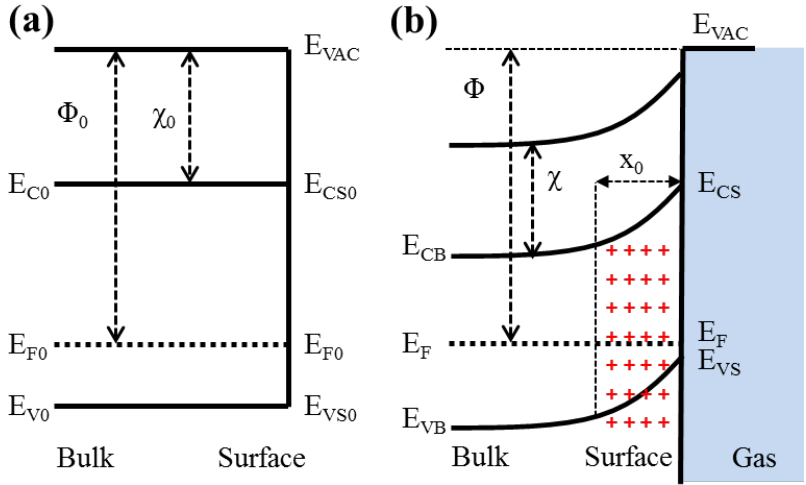
Figure 4. Band model showing the formation of a space charge region in a p-type TiO presence of surface acceptor states before ( a ) and after ( b ) adsorption of ambient oxygen (E : potential of the electron in vacuum; x vac